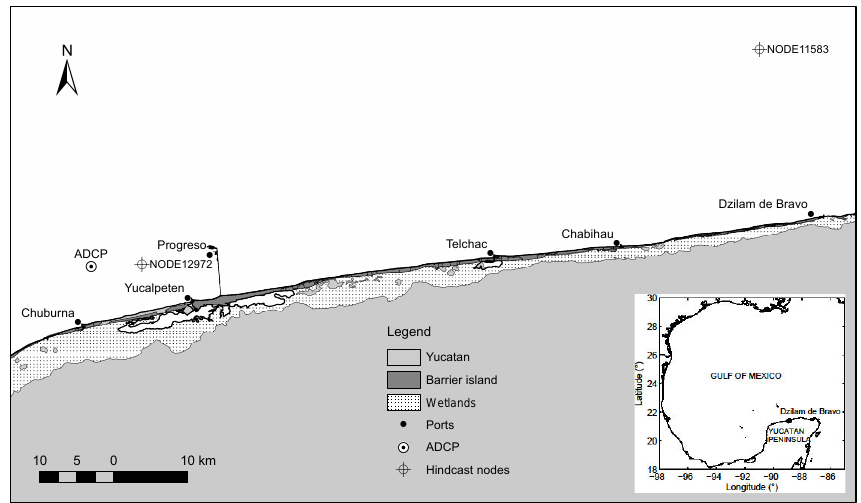
Figure 1. Location map indicating the study site (Dzilam de Bravo) at the barrier island backed by the wetlands and the mainland of Yucatán Peninsula, the position of the hindcast nodes used for the simulations, and the ADCP location in between Chuburna and Yucalpeten ports.